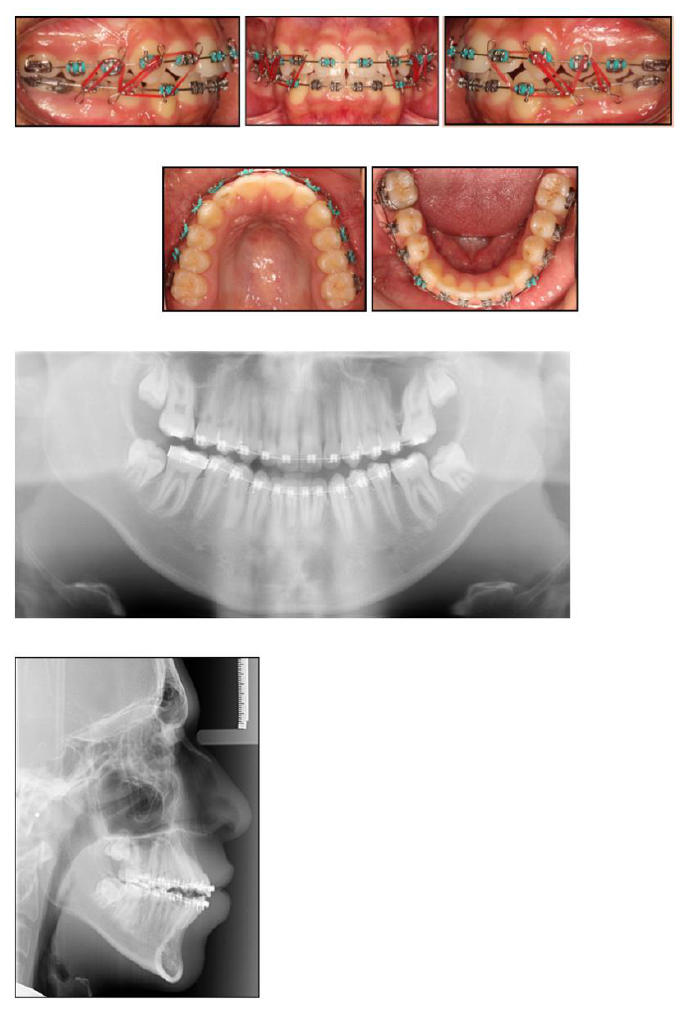
Figure 3. Near-end-of-treatment stage following space closure. Near-end-of-treatment radiographs revealed favourable third molar positioning. Intermaxillary elastics with a vertical vector were utilised to actively enhance interdigitation.